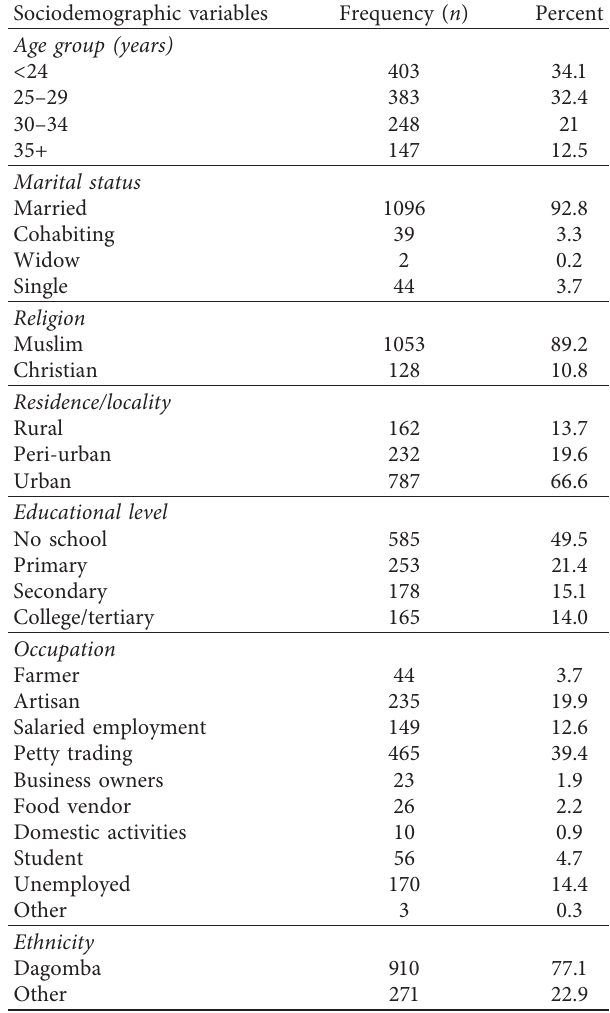
Table 1: Sociodemographic characteristics of study participants. Table 2: Reproductive health and obstetric history of